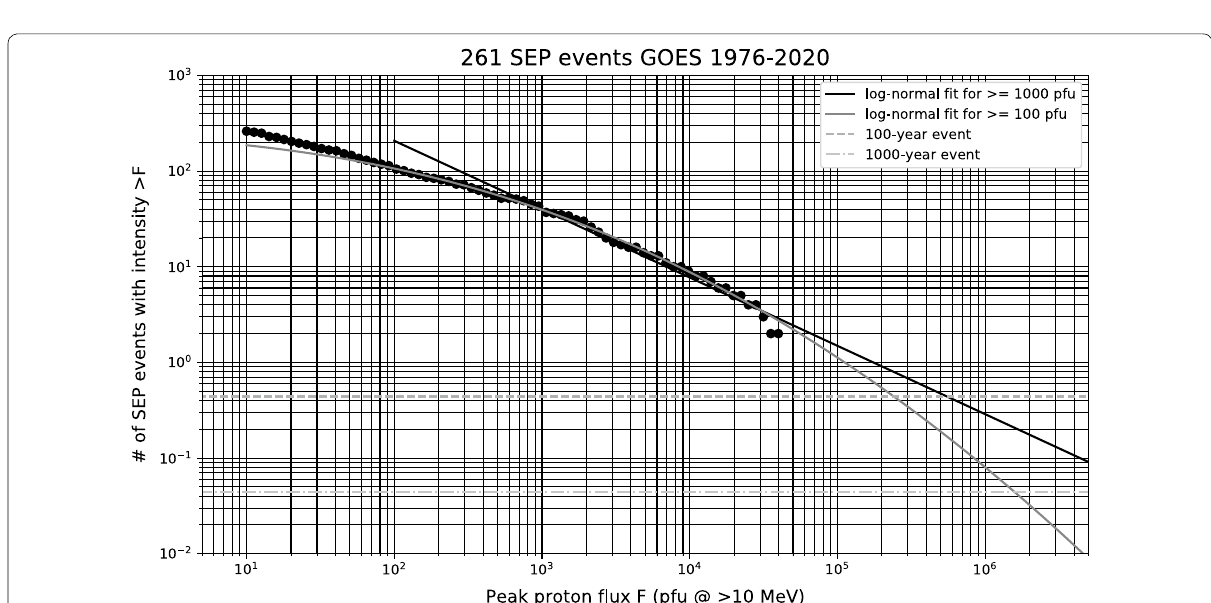
4.5, μ 2.4, and σ 0.28 = = =